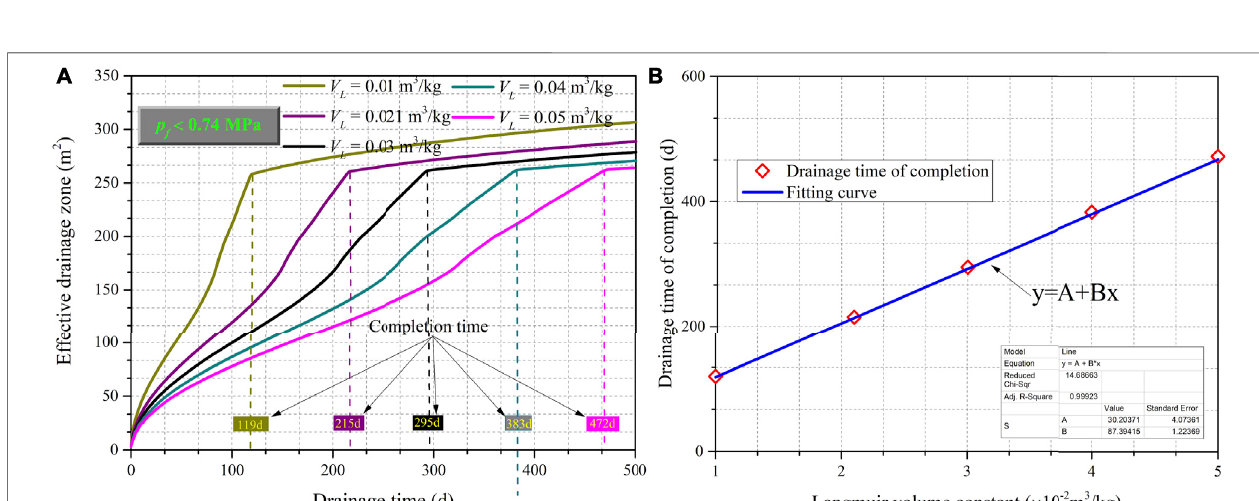
FIGURE 11 | Effect of changes in the Langmuir volume constant ( V L ) on drainage performance. (A) Effective drainage zone areas vs drainage time in days for fi ve different V L ’ s (B) Drainage completion time vs. Langmuir volume